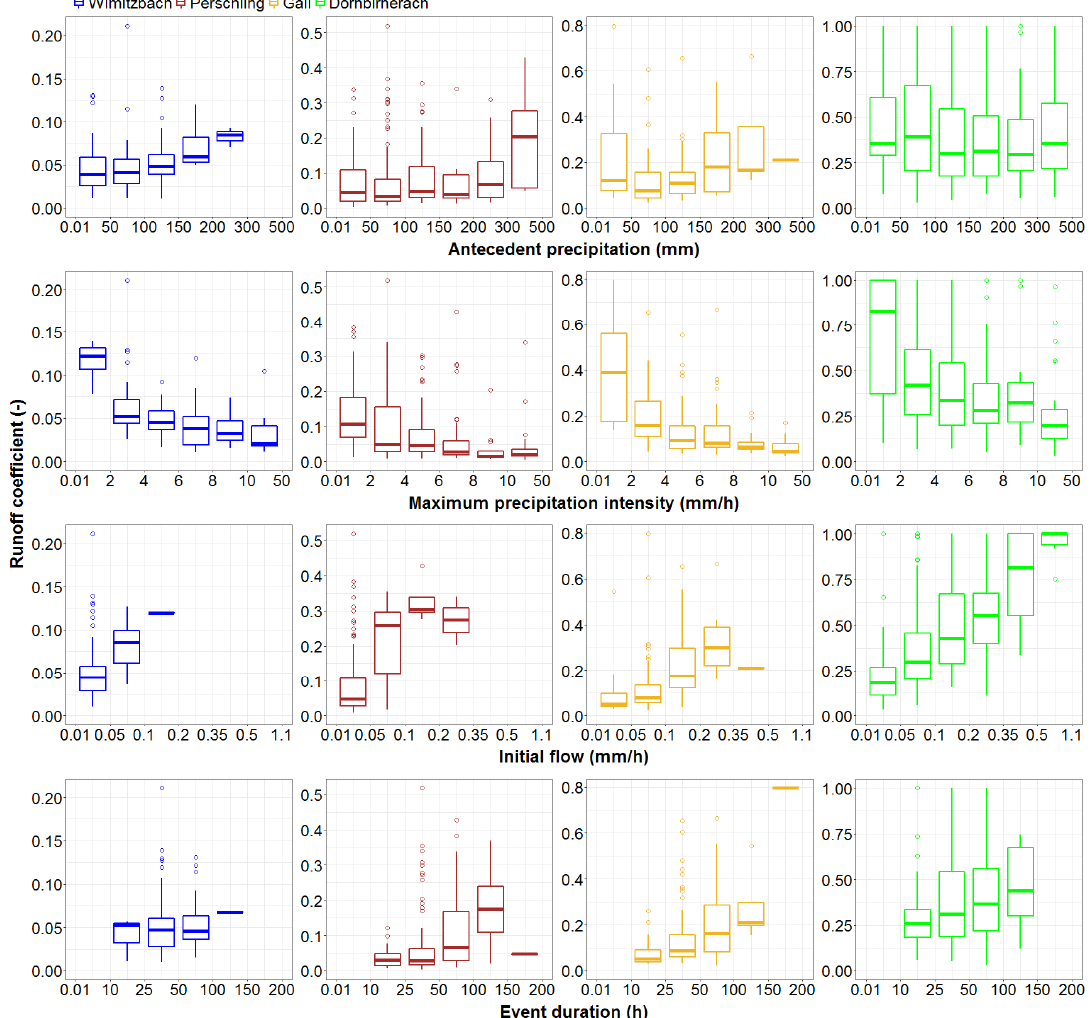
Figure 6. Variability of runoff coefficient (Rc) for different classes of antecedent precipitation, maximum precipitation intensity, initial flow prior to the event, and event duration in four selected catchments: Dornbirnerach, Gail, Wimitzbach, and Perschling. The changes are evaluated for events with precipitation volumes less than 50 mm.